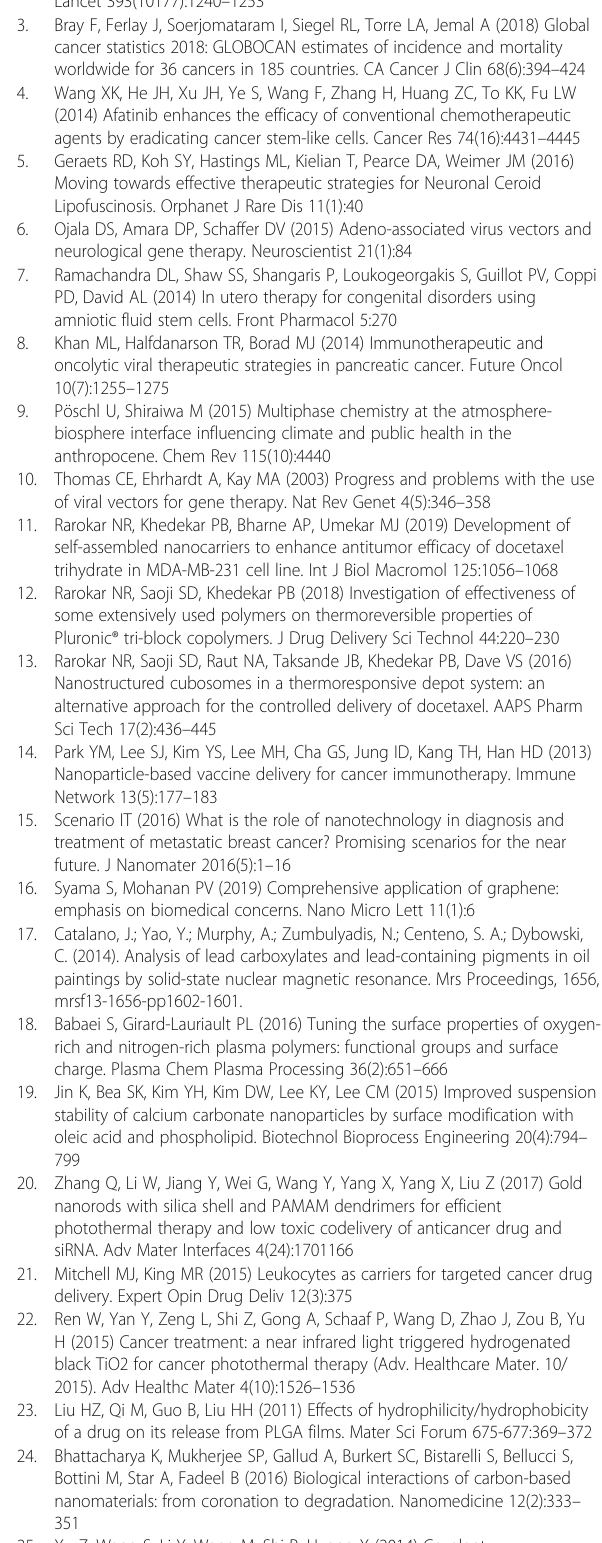
Additional file 2. Figure S2. Schematic illustration. (A) The preparation of PEG-GO-PEI-FA nanoscale delivery system. (B) The therapeutic process of the PEG-GO-PEI-FA/siRNA nanocomplexes in cancer